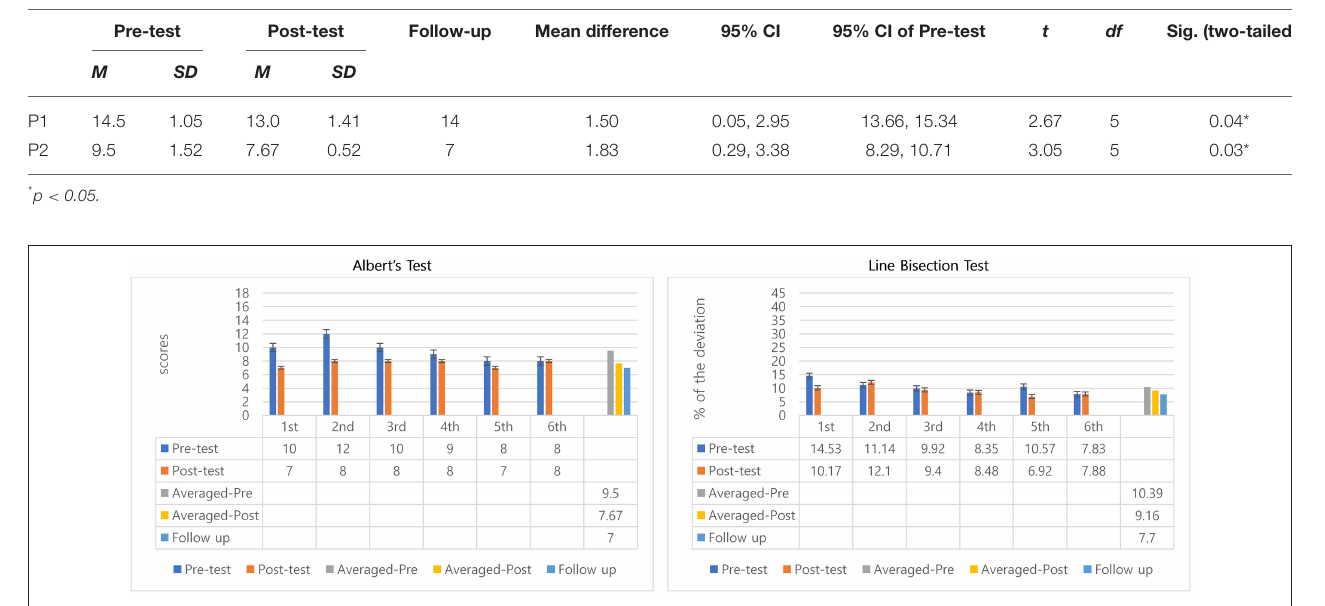
FIGURE 3 | Descriptive data for participant 2’s Albert’s test and line